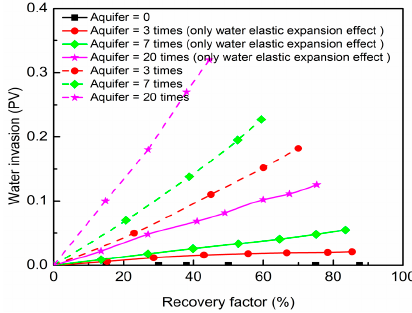
Figure 3. Water invasion versus recovery factor for different water invasion energies.